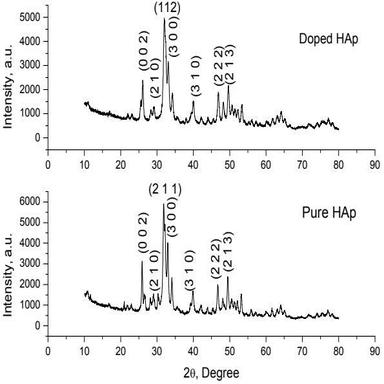
XRD pattern of pure and doped HAp powder